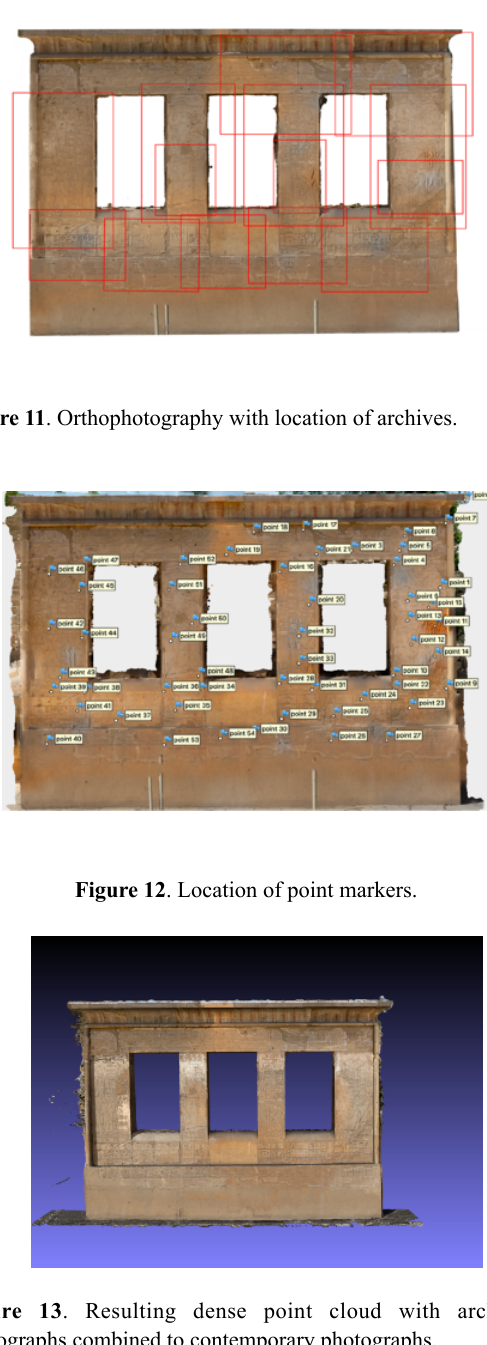
Figure 13 . Resulting dense point cloud with